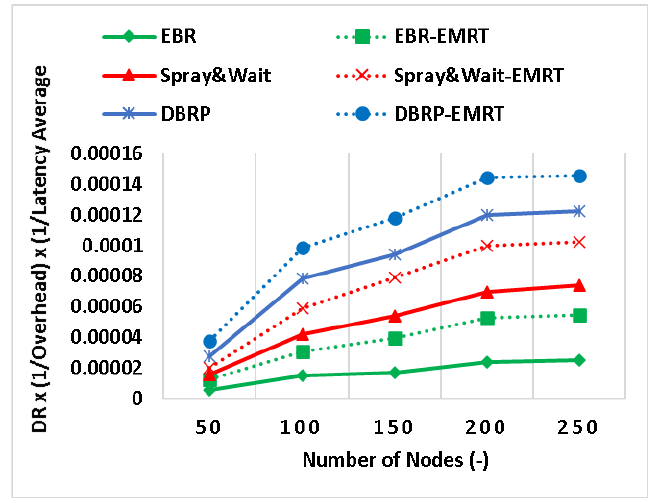
Figure 7. The DLO composite metric (DR × (1/overhead) × (1/latency average).